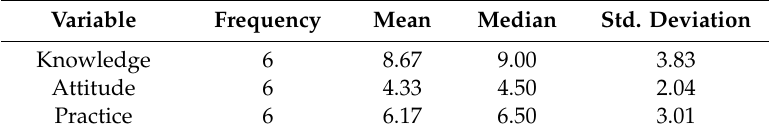
Table 6. Descriptive statistics for the overall knowledge, attitude and practice scores of the supervisors.